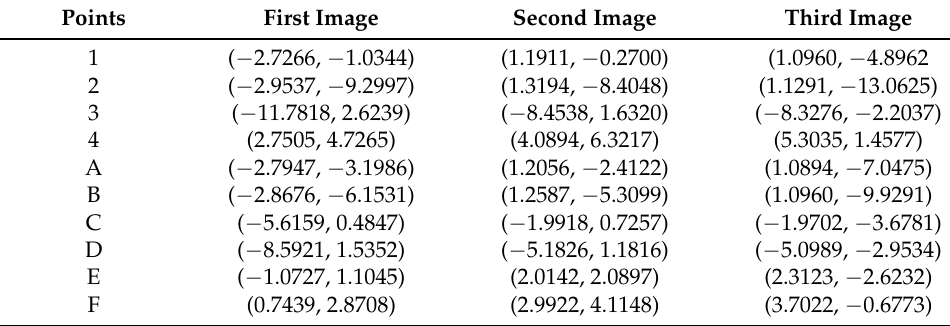
Figure 9. Points selection of third experiment. The image plane coordinates of the three images are shown in Table 13. Table 13. Image plane coordinates of the three